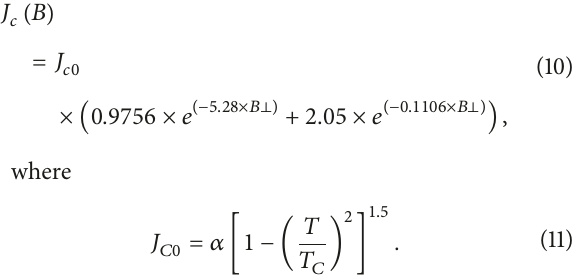
and 1. E denotes the electrical field criterion of 1 𝜇 V/cm 0